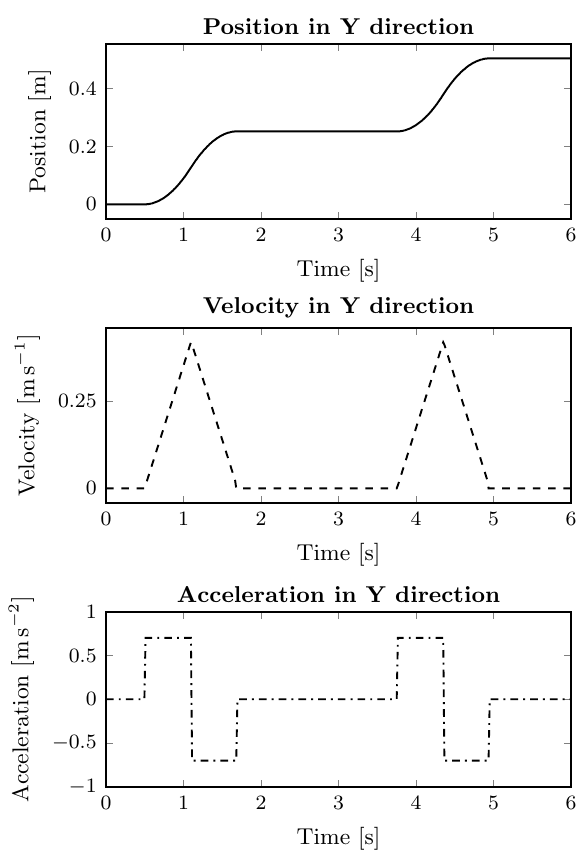
Figure 8: Trajectory for grabbing two 3D depth images of a propeller blade. The trajectory is per- formed along the Cartesian y